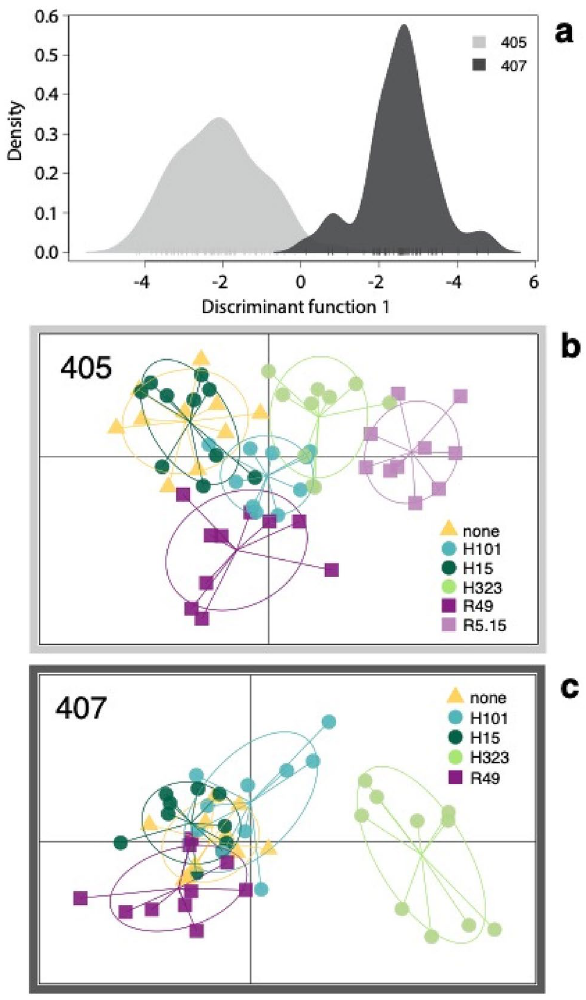
Figure 1. DAPC of aphid cuticular hydrocarbon profiles. ( a ) Shows the clear separation between aphid clones 405 and 407 (using 7 PCs). ( b ) Shows clone 405 without endosymbionts (yellow) and with different endosymbiont infections (using 16 PCs). ( c ) Shows clone 407 without (yellow) and with different endosymbiont infections (using